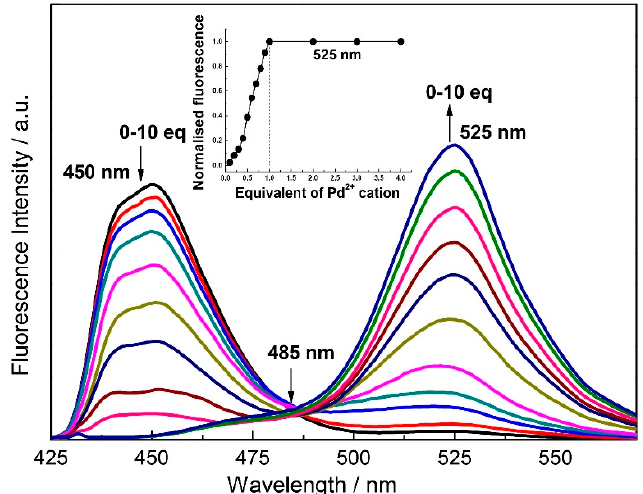
Figure 2. Fluorescence spectra of 1 (1.0 μ M) as a function of added PdCl 2 (10 μ M) in H 2 O:DMF (9:1) containing HEPES buffer (10 mM, pH 7.4). ( λ ex = 330 nm). Inset: mol ratio plot of emission at 525 nm.